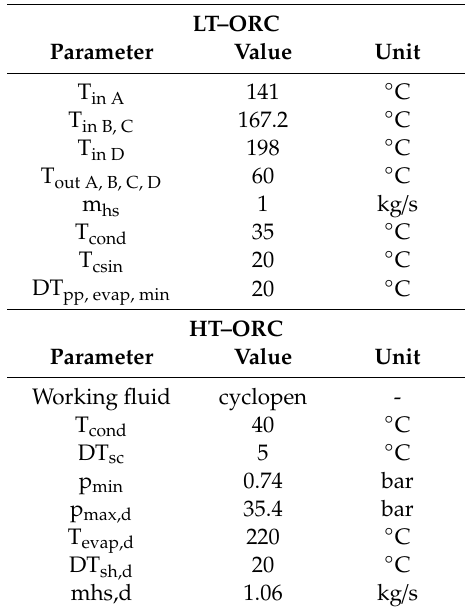
Table 7. LT–ORC and HT–ORC